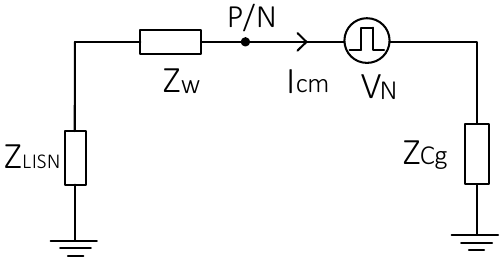
Figure 2. Common mode (CM) noise model of the conventional boost circuit.